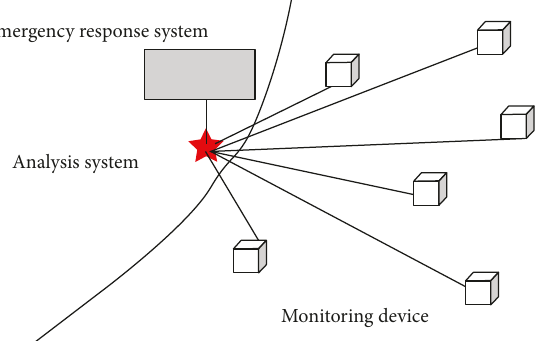
Figure 11: Prediction and monitoring system of radionuclide